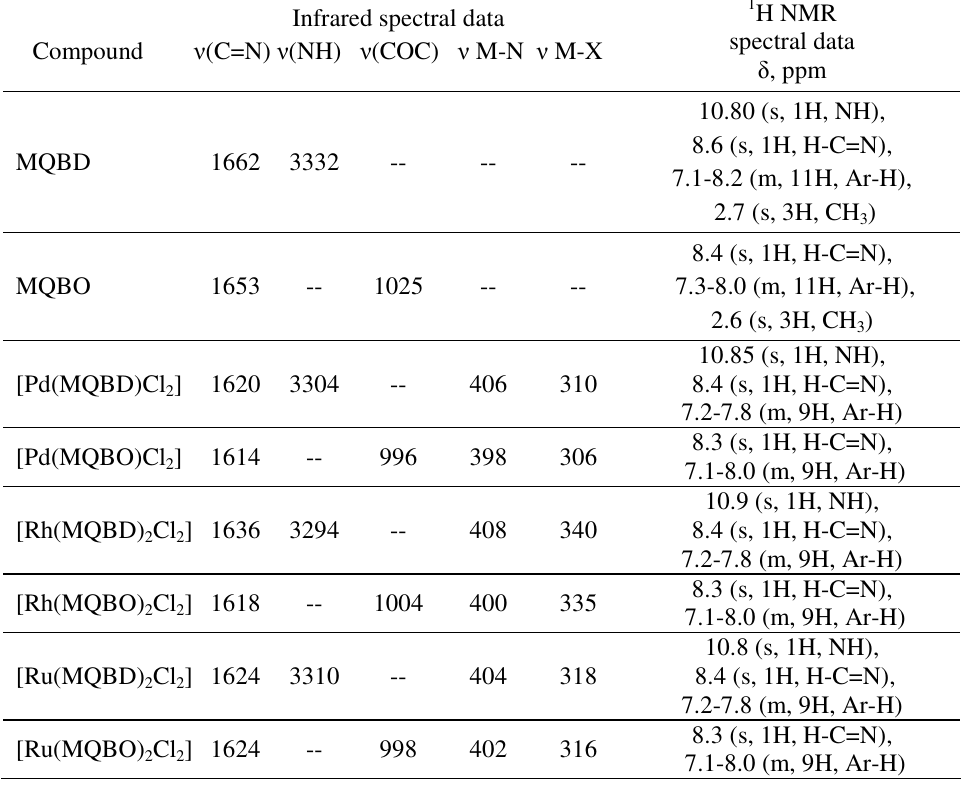
Table 2 . The IR and 1 H NMR spectral data of ligands and complexes.